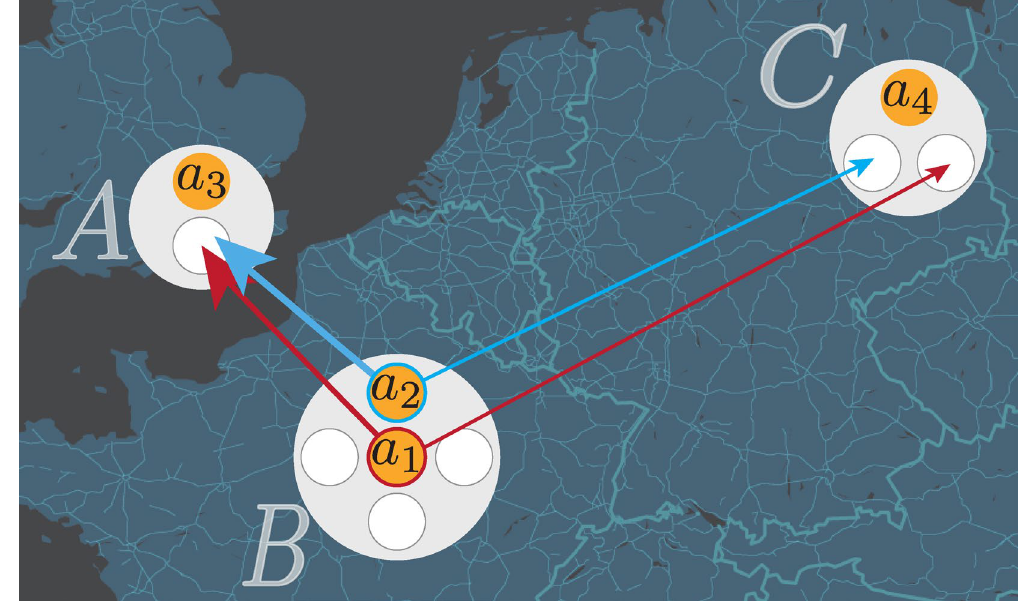
Figure 3. Example of relocation rules. Four agents ( a 1 , a 2 , a 3 and a 4 ) are hosted in three locations, A , B or C , representing London, Paris and Berlin. Each location has a maximum number of available positions illustrated by small circles: N A = 2 , N B = 5 and N C = 3 . In this image, agents a 1 and a 2 compute the rescaled fitness of the available locations ( A and C ) and rank these location accordingly. Here, we have assumed that A and C have the same fitness ( F A ( t ) = F C ( t ) ), but A is closer to B than C ( � i , A < � i , C for i = 1, 2 ). For this reason, both a 1 and a 2 express a preference for A over C . Since location A has N A = 2 and one position is already taken, A must decide to accept either a 1 or a 2 , depending on their